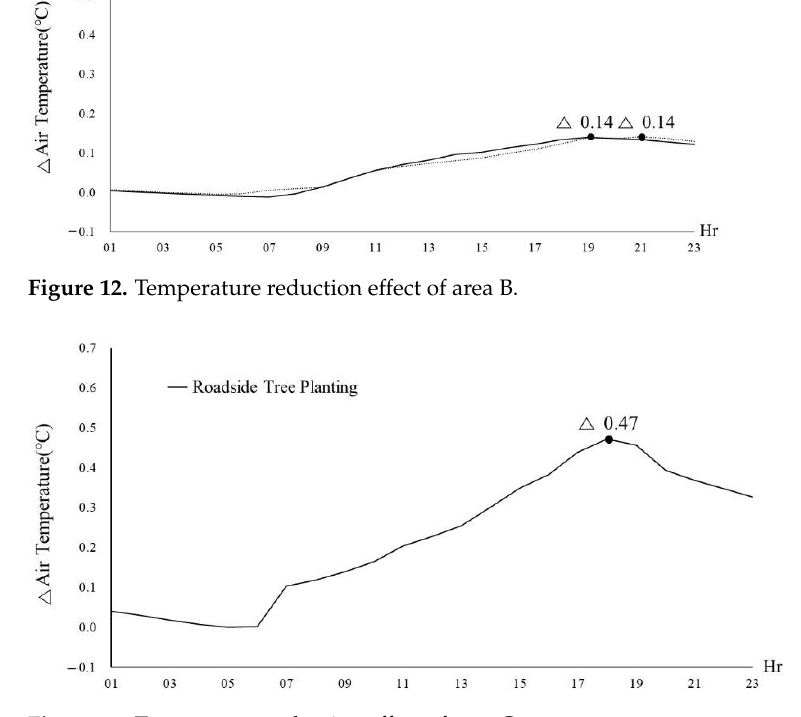
Figure 13. Temperature reduction effect of area C. Table 5. Temperature reduction effect of rooftop greening and roadside tree planting.